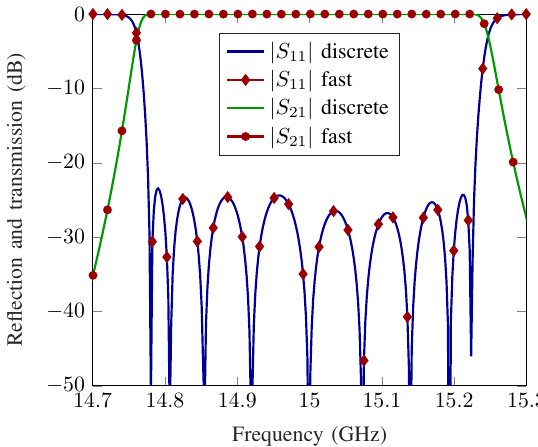
Figure 4. S-parameter comparison between fast sweep and discreet sweep for the nine-cavity filter. P =